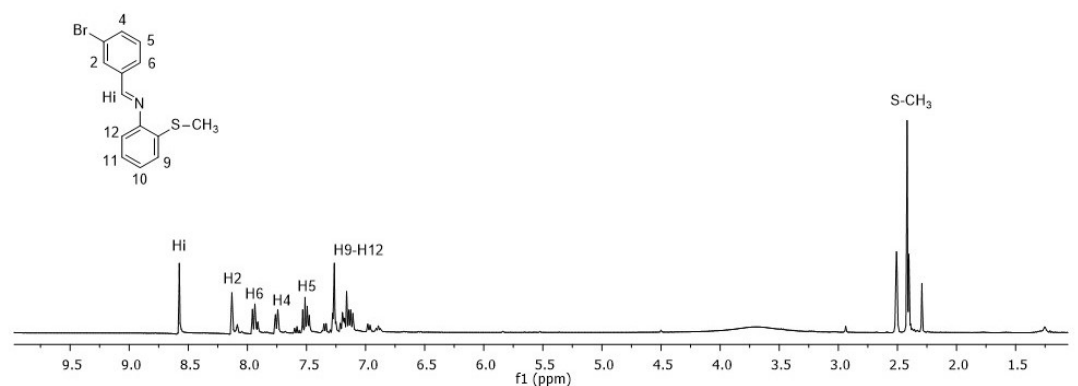
Figure 1. 1 H NMR spectrum of ligand b in DMSO-d6.